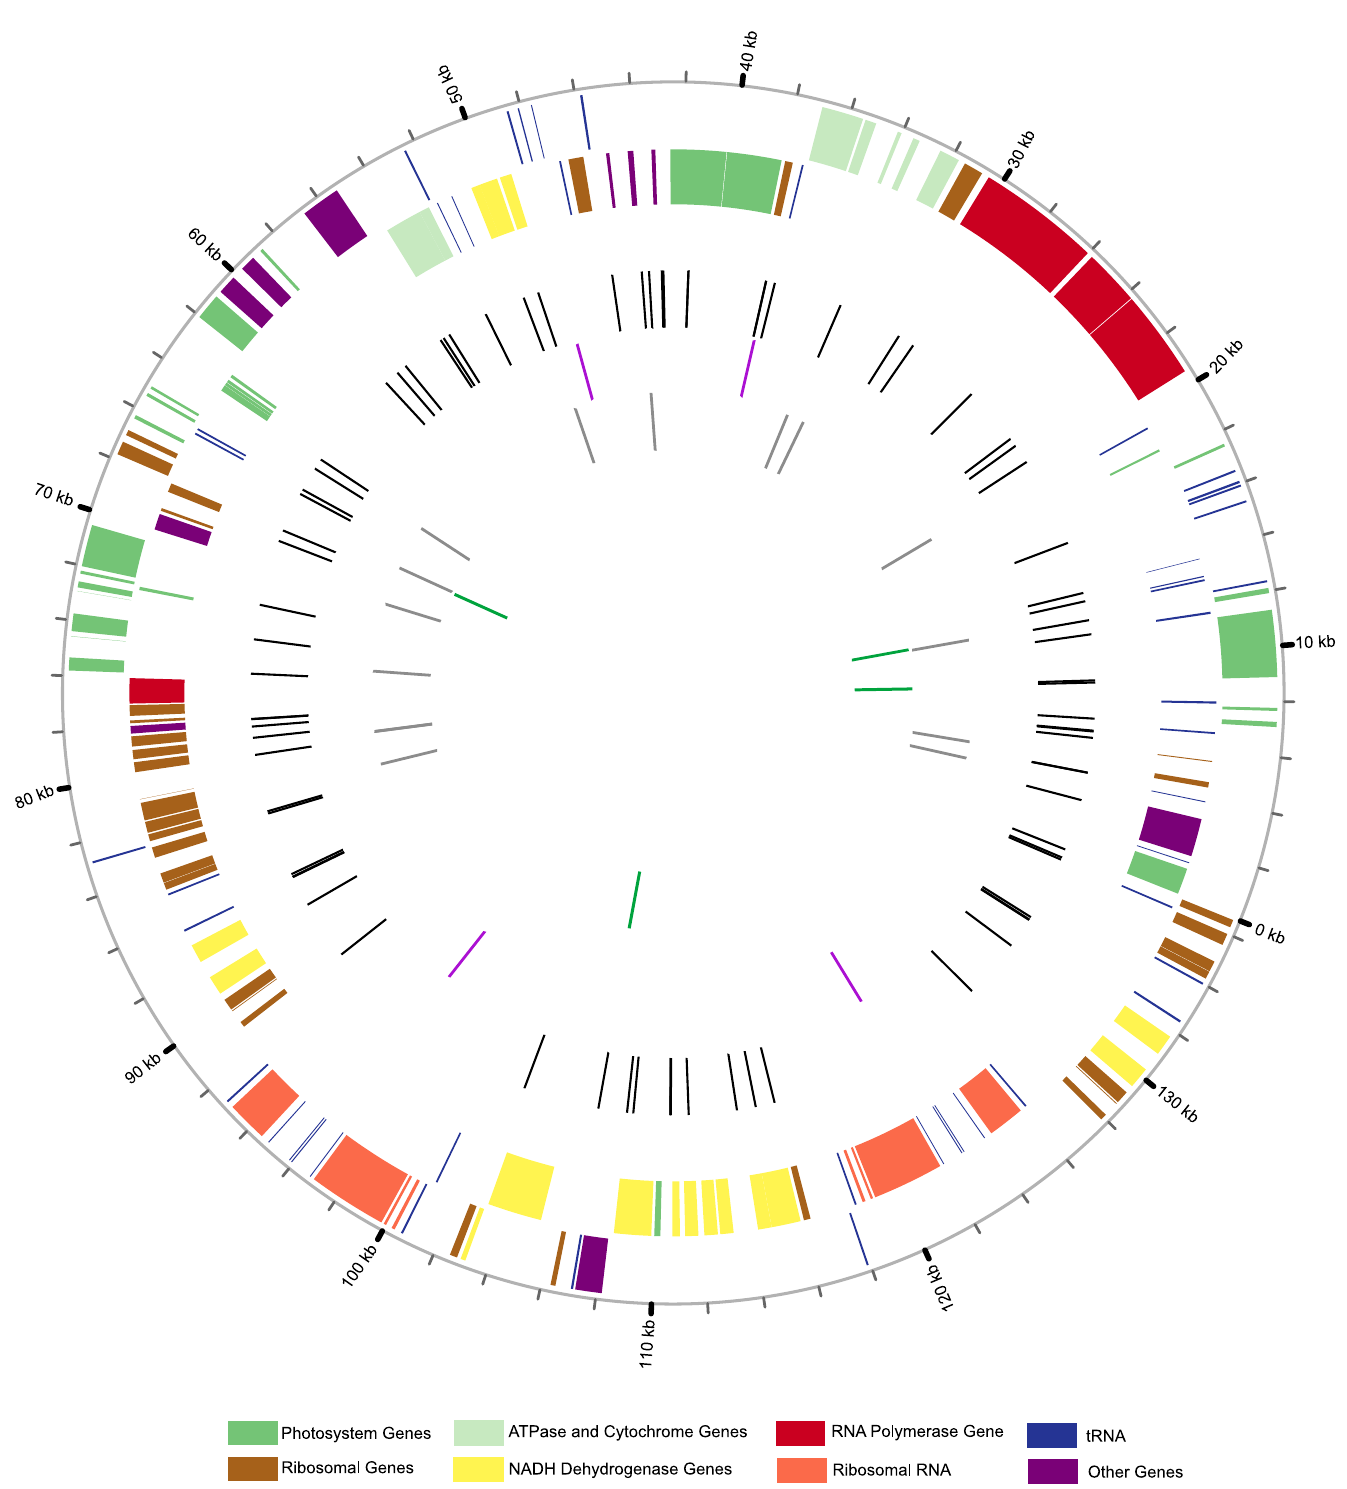
Fig 1. The simplified schematic diagram showing the chloroplast genome information and variation maps of Chikusichloa mutica . From outside to inside,all tracks independently represent: 1) the forward strand coding genes; 2) the reverse strand coding genes; 3) the numberand distributionof singlenucleotidesubstitutions (SNPs) (black bar color); 4) the number and distribution of non-repeat insertion-deletions(Indels) (purplebar color); 5) the numberand distributionof homopolymer structures (grey bar color); 6) the number and distributionof repeat Indels (green bar color). The different functionalgroups of chloroplastcodinggenes are colored at the bottom. The diagram was generated with Circos v0.67 (http://circos.ca/).